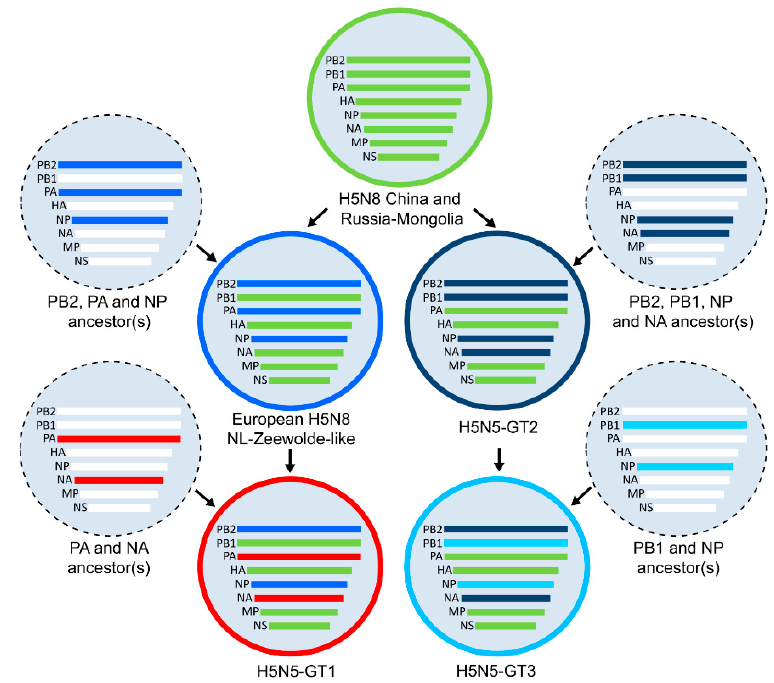
Figure 1. Gene constellations of HPAI H5N5 genotypes. Schematic representation of reassortment events that resulted in the emergence of three highly pathogenic avian influenza (HPAI) H5N5 genotypes detected during the HPAI H5 2016-2017 epidemic (H5N5-GT1, H5N5-GT2 and H5N5-GT3). Novel genes were obtained by reassortment of HPAI viruses with co-circulating low pathogenic avian influenza (LPAI) ancestor viruses. Gene segments are colored according to their phylogenetic cluster, as shown in Figure S1. PB2, polymerase basic protein 2; PB1, polymerase basic protein 1; PA, polymerase acidic protein; HA, hemagglutinin; NP, nucleoprotein; NA, neuraminidase; MP, matrix protein; NS, nonstructural